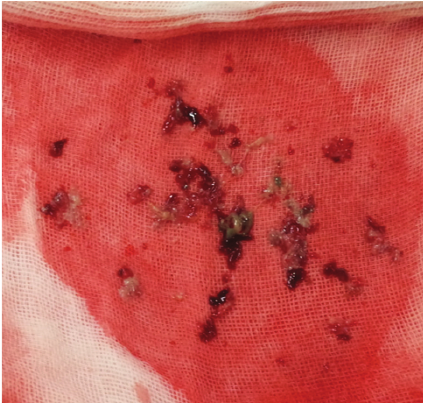
Figure 3: Thrombi caught in the IVC filter were aspirated using a 7-Fr sheath and a 50 mL syringe via the right femoral vein. Many thrombi were removed by the aspiration